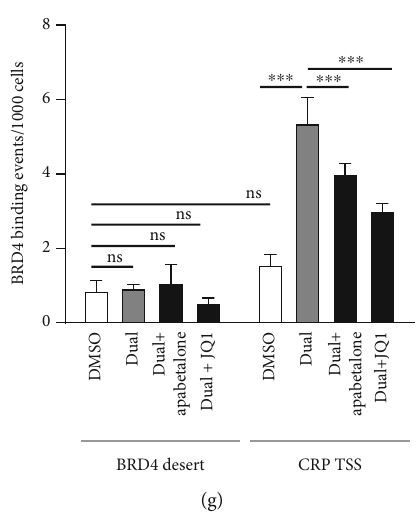
Figure 3: BET proteins contribute to cytokine-mediated induction of the CRP gene. CRP gene expression changes in HepaRG ™ cells (a) and human primary hepatocytes (b) measured by rtPCR in response to IL-6, IL-1 β , or combined (dual) cytokine treatment (2 h). Apabetalone pretreatment (1 h, 25 μ M) counters mRNA induction in response to single or dual cytokine treatment. Gene expression is graphed relative to DMSO-treated cells. Representative data from three independent repeats is shown. Data is presented as a mean ± S : D : (c) MZ-1 degrades BRD2, BRD3, and BRD4 protein in HepaRG ™ cells in a dose-dependent manner. Representative Western blot data is shown. (d) Quanti fi cation of BRD2, BRD3, and BRD4 protein bands relative to β -actin. Data is presented as the mean of four independent replicates ± S : D : (e) BET degradation by MZ-1 signi fi cantly repressed dual cytokine-induced CRP transcription. Representative data from three independent repeats is shown. Data is presented as the mean ± S : D : (f, g) Dual cytokine stimulation (2 h) increases BRD2 (f) and BRD4 (g) occupancy on the CRP transcription start site (CRP TSS) but not in a BET protein-lacking region (desert) as determined by ChIP. Pretreatment (1 h) with apabetalone (25 μ M) or JQ1 (0.5 μ M) reduces BRD4 association with the CRP promoter (g). Samples were processed in triplicate. Data is presented as the mean ± S : D : Statistical signi fi cance was determined through 1-way ANOVA followed by Tukey ’ s multiple comparison test, where ∗ p < 0 : 05 , ∗∗ p < 0 : 01 , ∗∗∗ p < 0 : 001 , and ns means no signi fi cant di ff